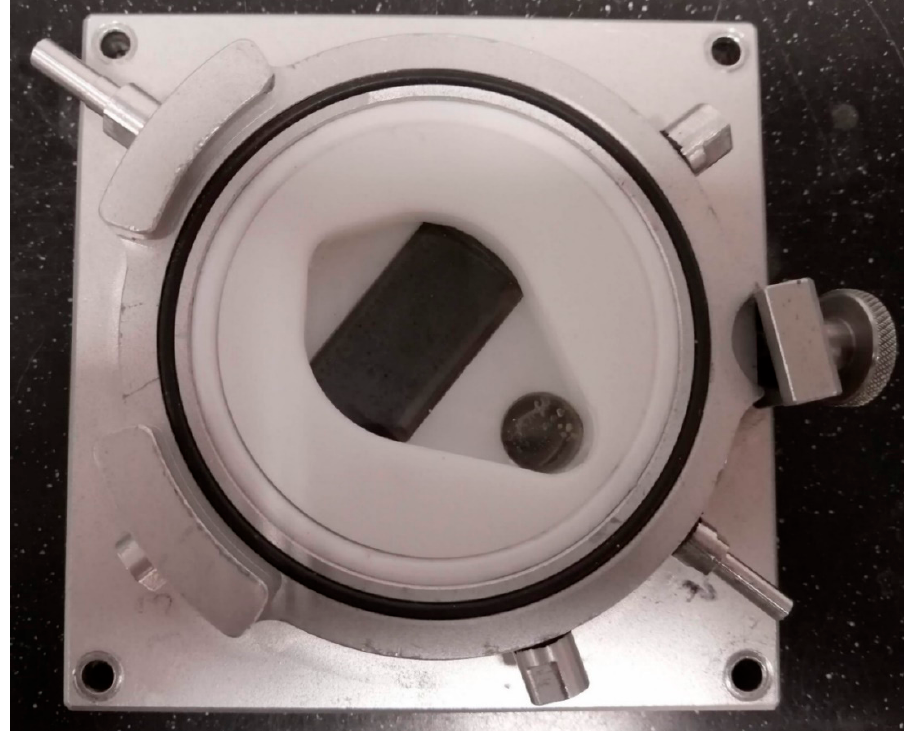
Figure 2. Custom laser ablation cell for analysing rectangular trans-vertical MLA